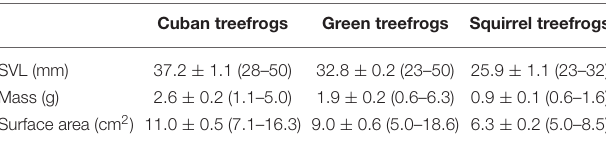
TABLE 1 | Summary of morphometric measurements for frogs used in this study, including the mean ± SE (range) snout-vent length (SVL), body mass, and surface area (adjusted to account for the water-conserving posture; see methods for details) for each species. Cuban